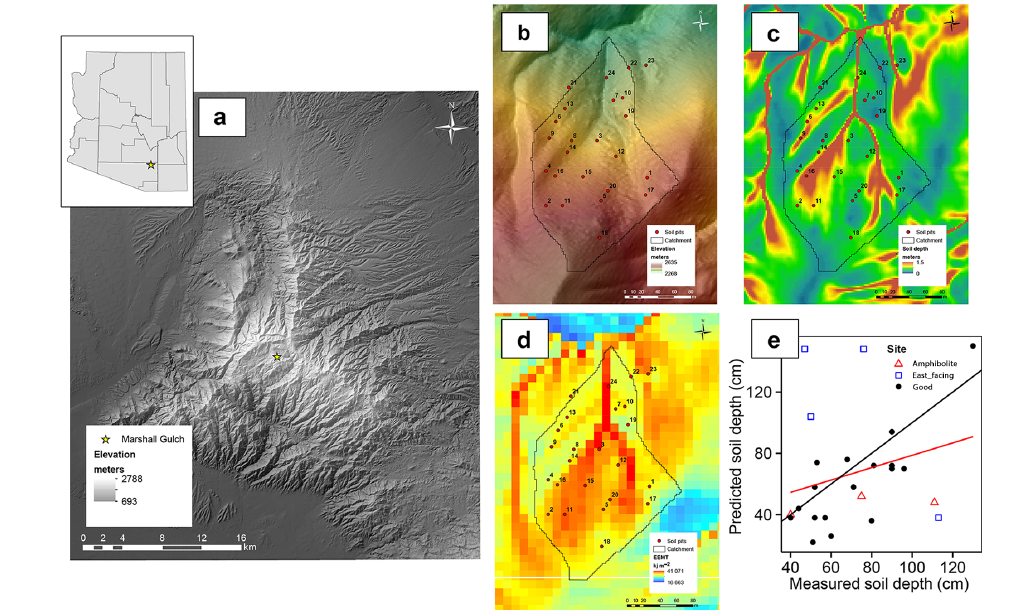
Figure 2. Marshall Gulch study site. (a) Location of the Santa Catalina Mountains and the Marshall Gulch catchment within Arizona, USA; (b) elevation of the granite sub-catchment of Marshall Gulch; (c) predicted soil depth in the granite sub-catchment (Pelletier and Rasmussen, 2009a); (d) EEMTv2.0 in the granite sub-catchment (Rasmussen et al., 2015); (e) mismatch between the measured soil depths and predicted soil depths.